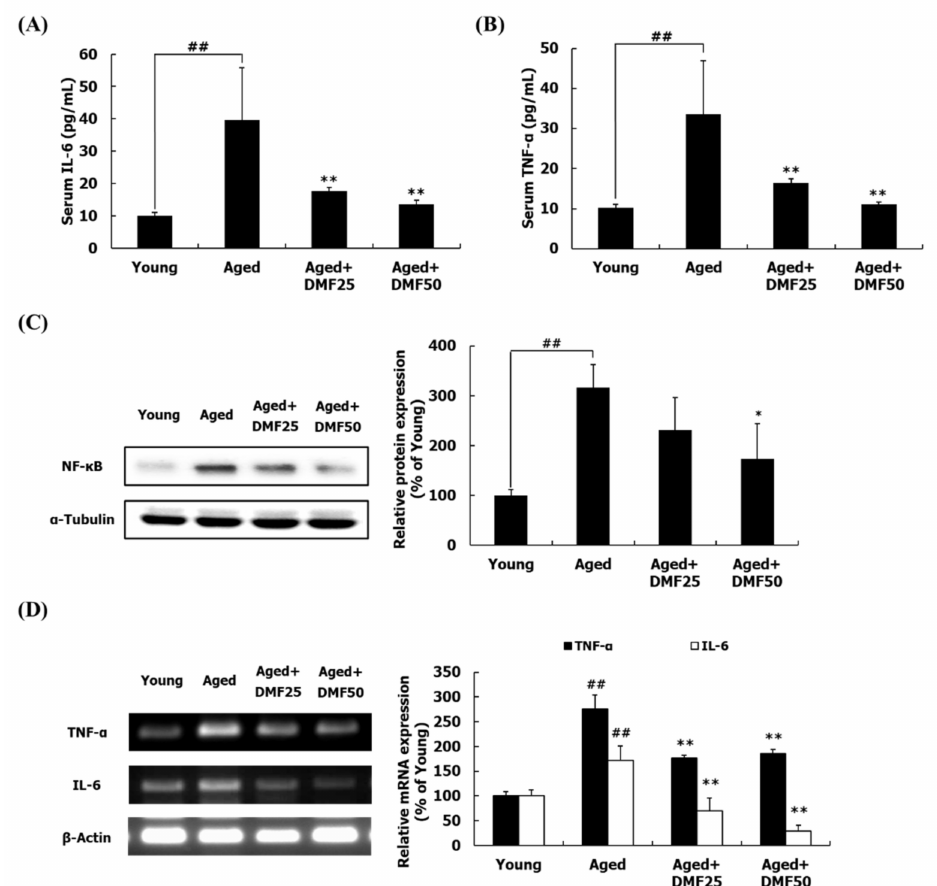
Figure 7. E ff ects of DMF on inflammatory responses in serum and the gastrocnemius muscle. ( A ) Serum IL-6 level. ( B ) Serum TNF- α level. ( C ) Relative protein level of NF- κ B. ( D ) Relative mRNA levels of IL-6 and TNF- α . Results are presented as mean ± SD; ## p < 0.01 vs. Young group; * p < 0.05, ** p < 0.01 vs. Aged